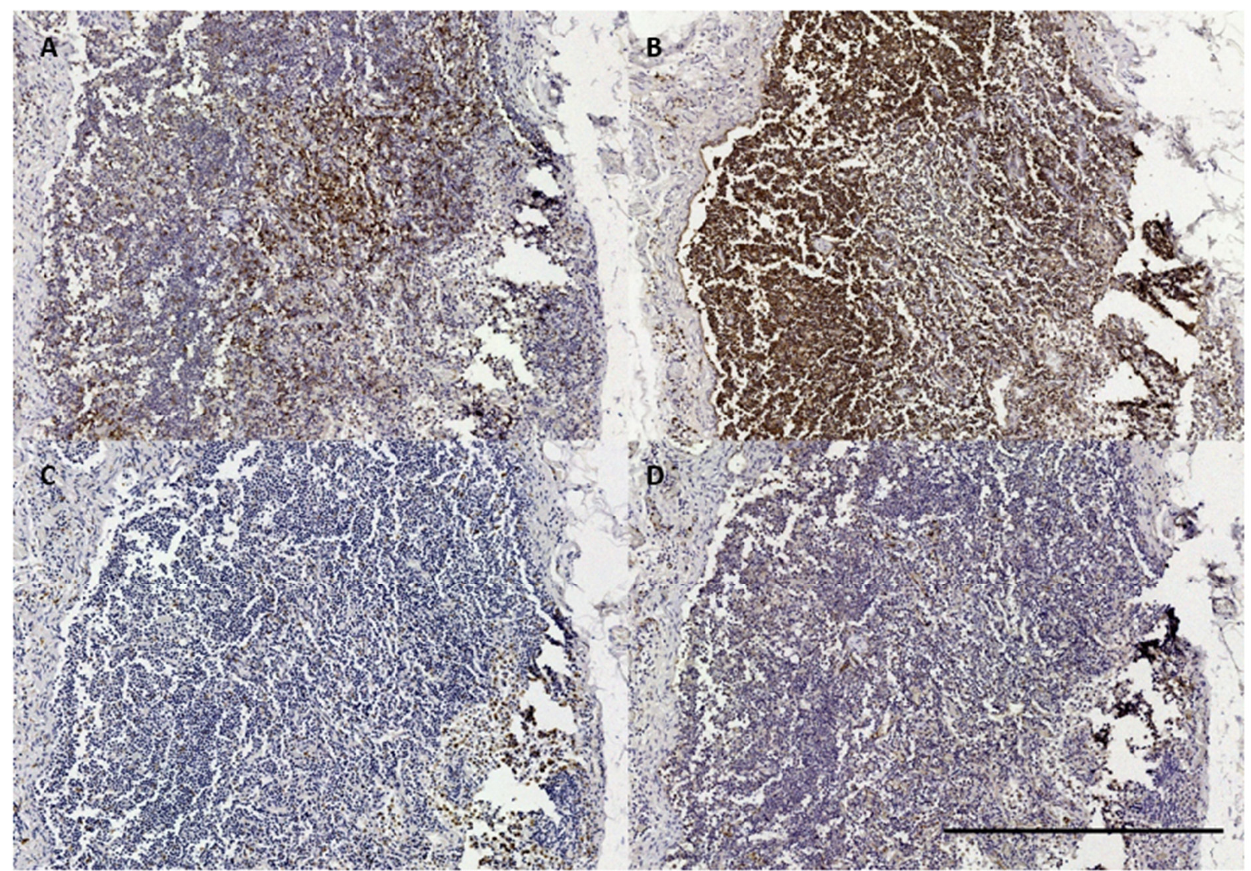
Figure 13. The histological images of IHC in a striped dolphin nodular lymphoid tissue (ID362/18). ( A ) CD3; ( B ) CD20; ( C ) Iba-1; ( D ) vWf. Scale bar = 500 µm.